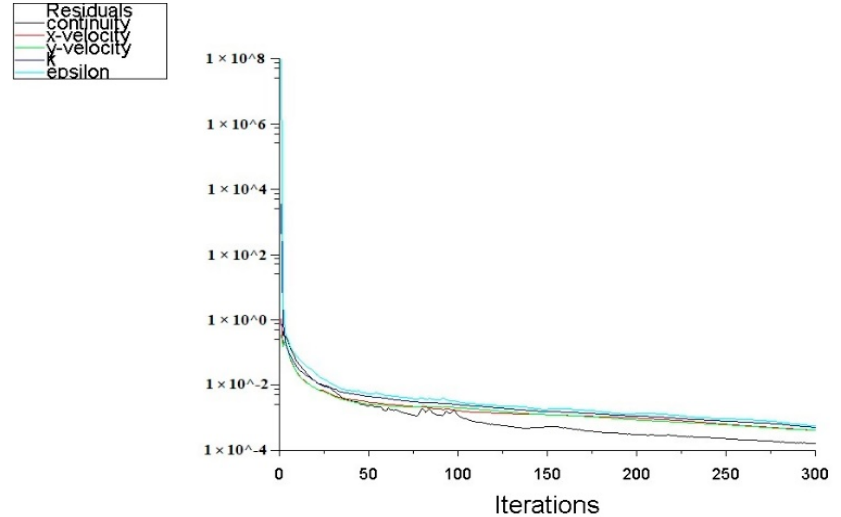
Figure 6. Residual monitoring during the simulation.